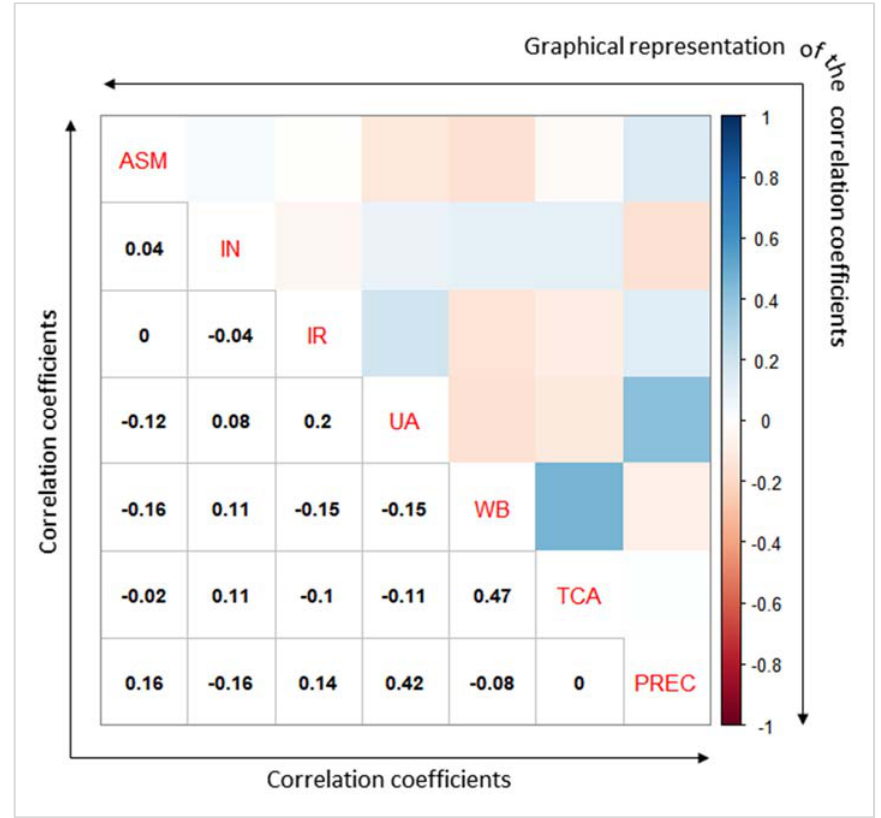
Figure 8. Correlation matrix of the input parameters.